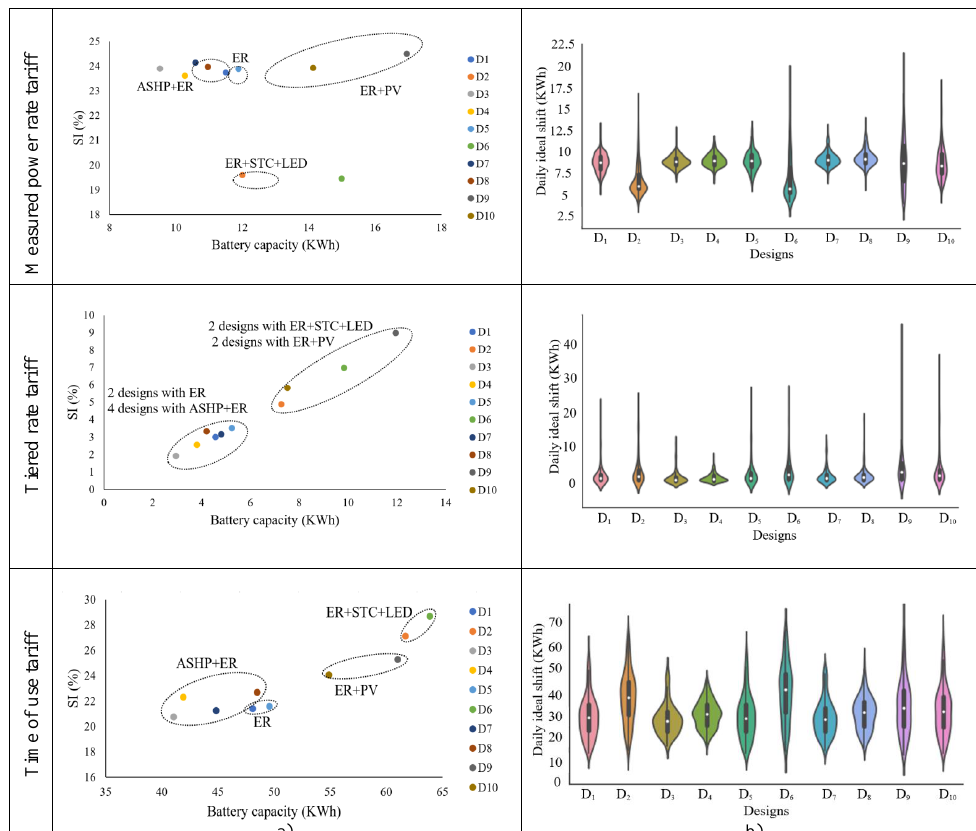
Figure 9. Visualization of designs based on SI, cost-effective battery size, and daily ideal shift ( a ) The relationship between the SI and cost-effective battery size. ( b ) The violin plots of the daily shifts for the ten designs in the reference